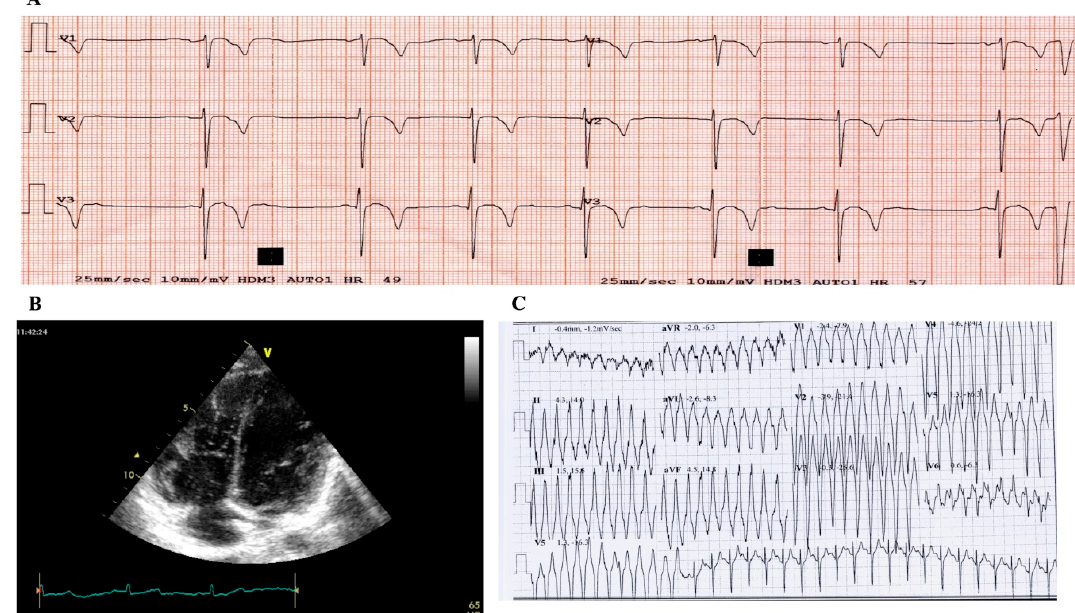
Figure 1. Clinical instrumental cardiac signs of the index case. ( A ) T-wave inversion (TWI) in anterior leads at electrocardiogram (ECG); ( B ) increased trabeculation of the right ventricle at echo-ultrasonography; and ( C ) non-sustained ventricular tachycardia (NSVT), with left bundle branch block morphology and inferior axis, during stress test at ECG.